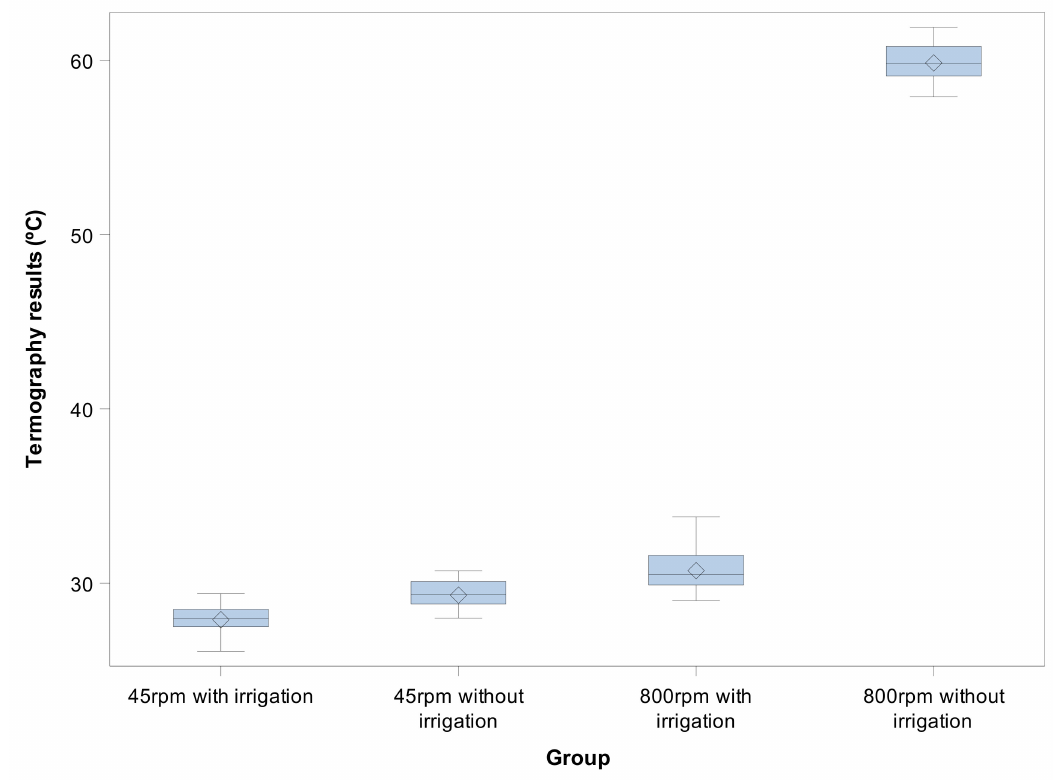
Figure 8. Box plots of the thermographic results ( ◦ C) of the experimental groups. The horizontal line in each box represents the median